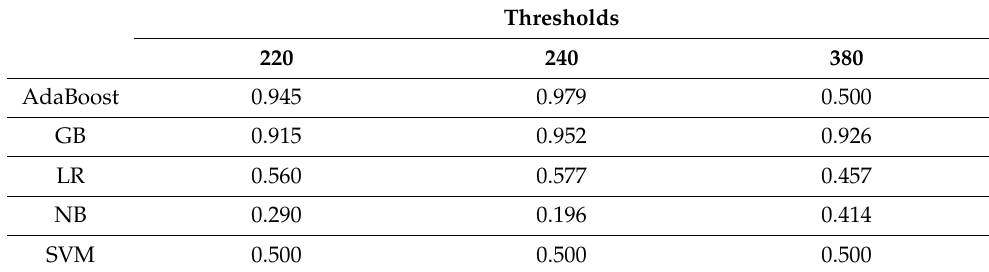
Table 2. AUC of classification algorithms: AdaBoost, Naive Bayes (NB), Linear Regression (LR), Support Vector Machines (SVM), and Gradient Boosting (GB) for BrAC thresholds of 220, 240, and 380.